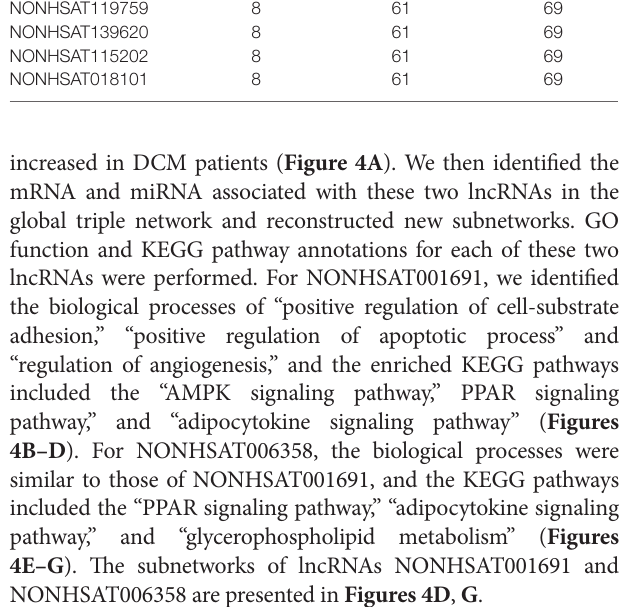
Frontiers in Genetics |